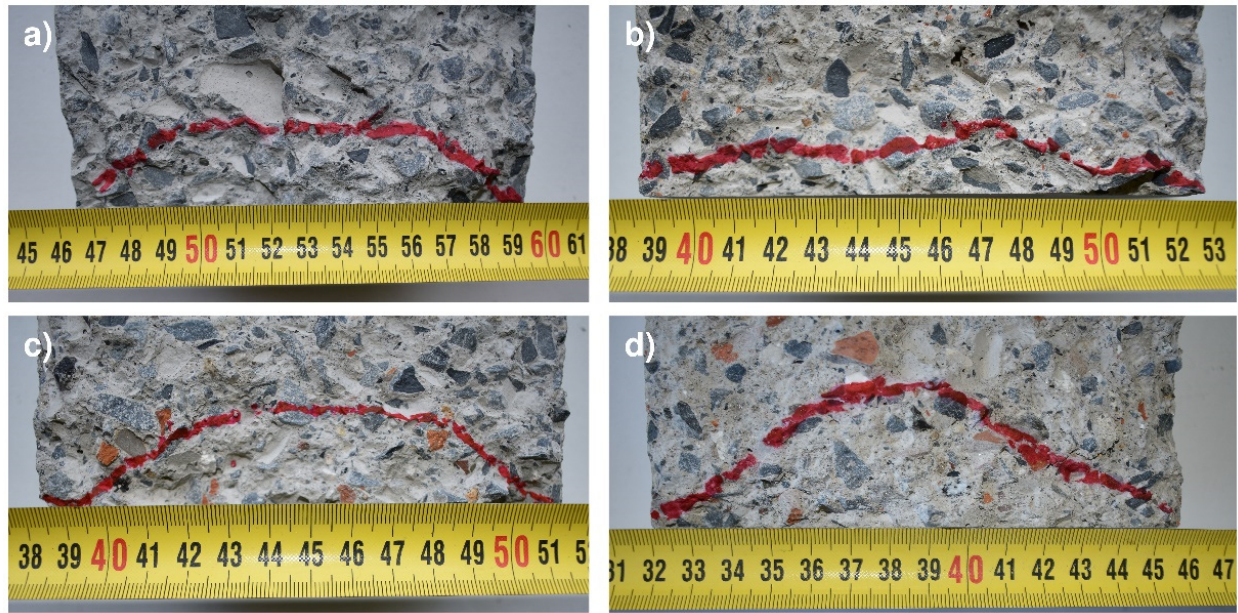
Figure 10. Penetration fronts of the concretes: ( a ) M1; ( b ) M3; ( c ) M6; and ( d ) M9.